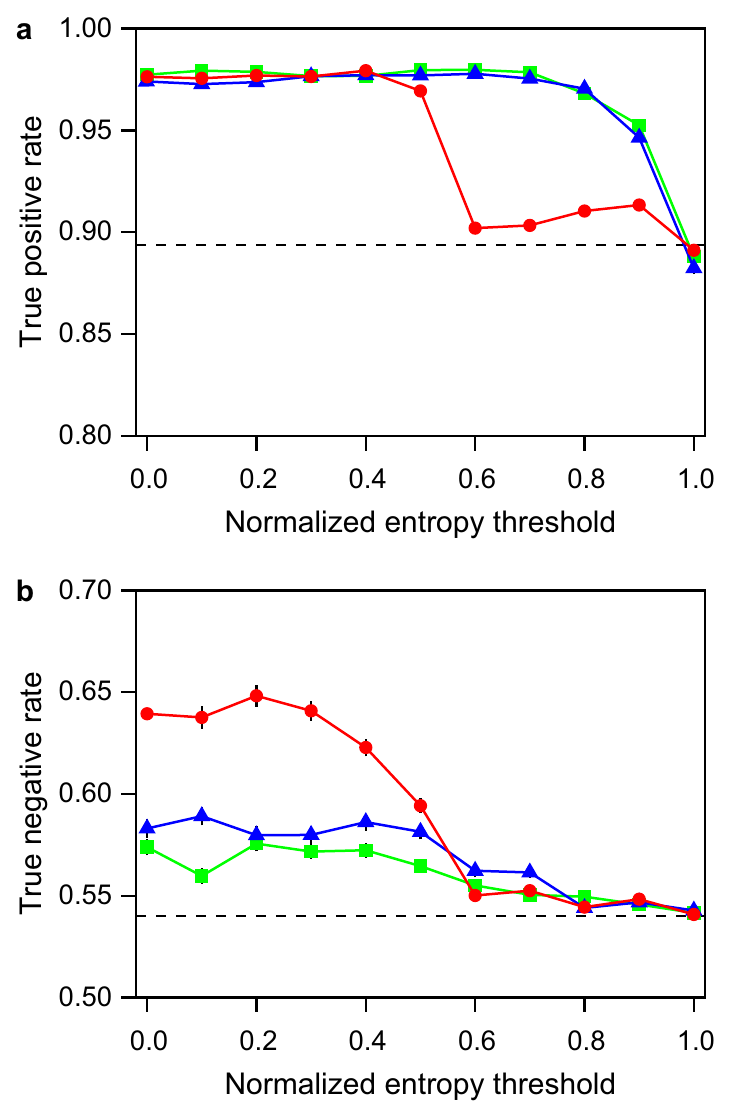
Fig 4. (a) True positive rates and (b) true negative rates over entropy threshold. Colors correspond to Fig 2 (square: case 1, filled circle: case 2, triangle: case